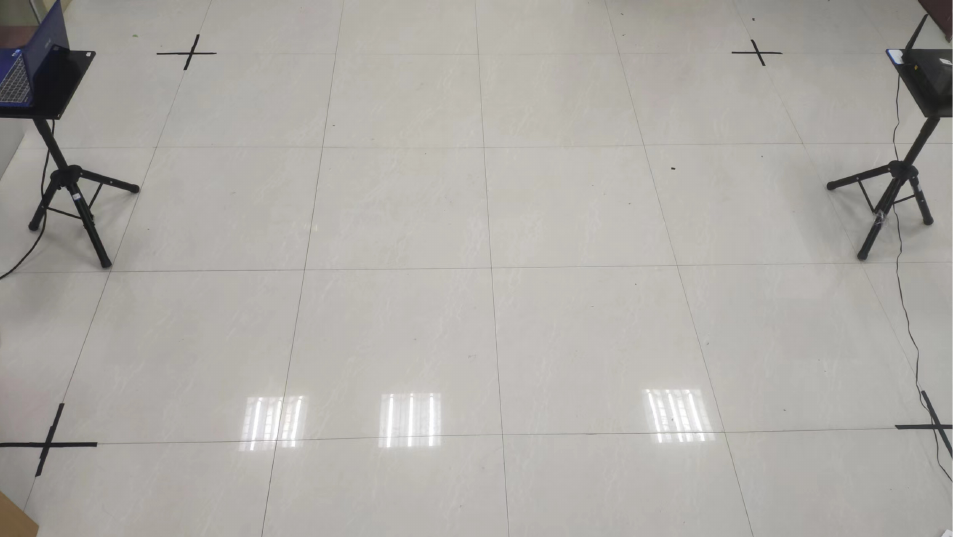
Figure 2. The area where the CSI data were collected. The crossbelt marks the boundary of the area, which is 2.4 m × 3.2 m in